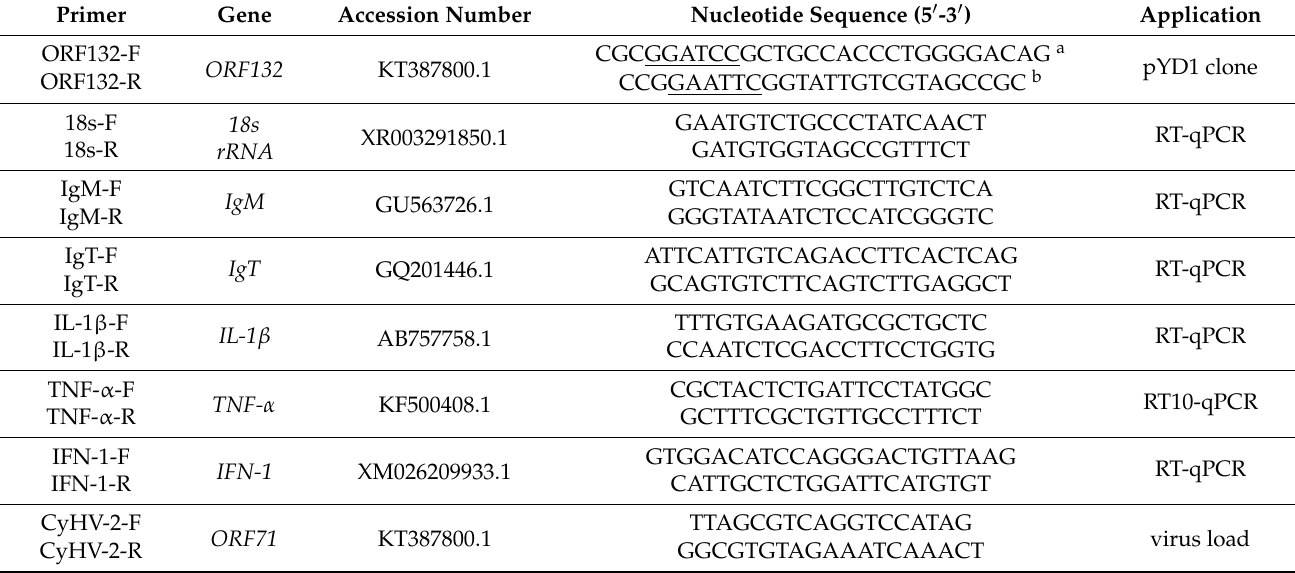
Table 1. Oligonucleotide primers used in this